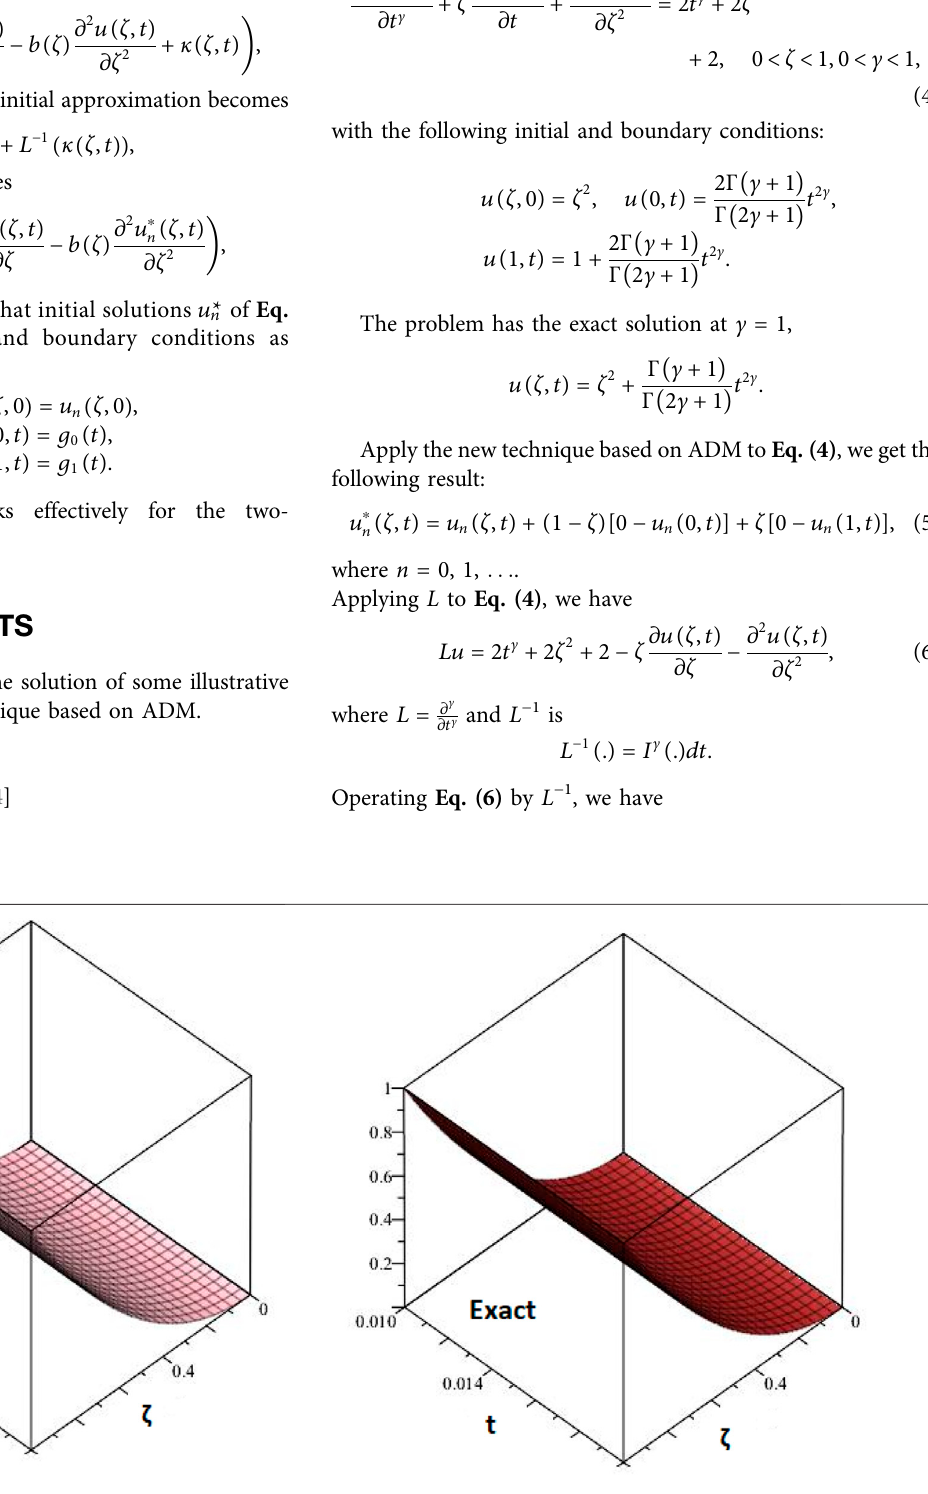
FIGURE 1 | 3D plots for the exact and analytical solution at γ =1 for Example 1.